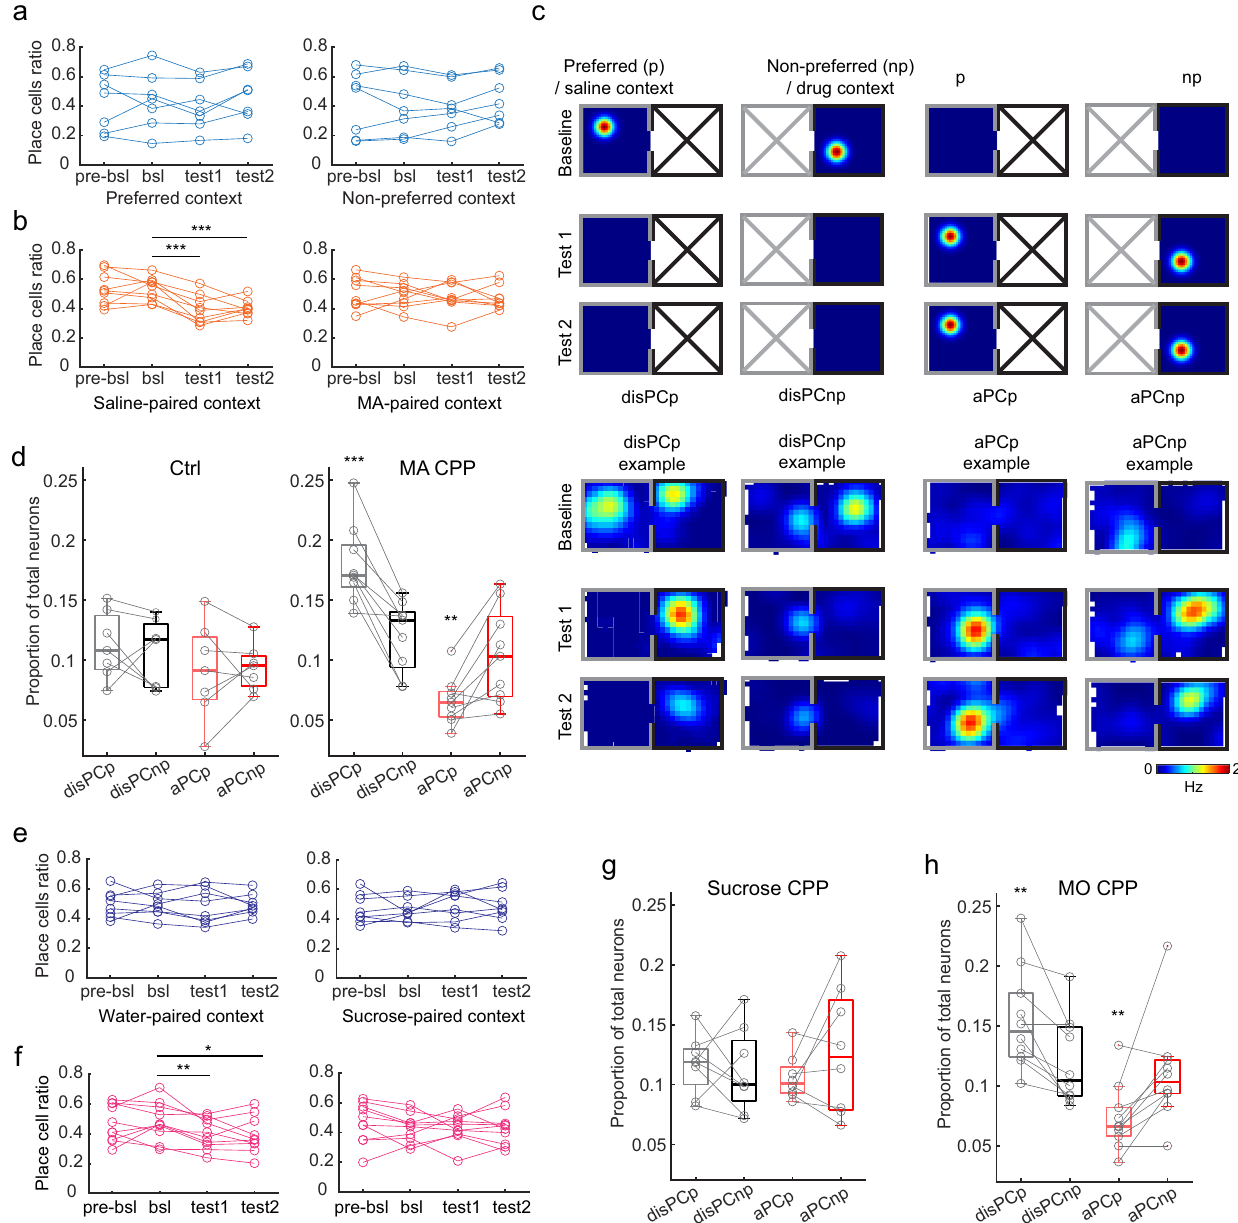
Fig. 2 | Drug-conditioning results in an unbalanced rate of place cell turnover across the two CPP contexts. a The ratio of place cells over the total number of neurons in Ctrl mice in the preferred (F(3, 6)=1.21, p =0.34, n =7 mice, repeated measuresANOVA)andnon-preferredcontext(F(3,6)=0.85, p =0.49),respectively.